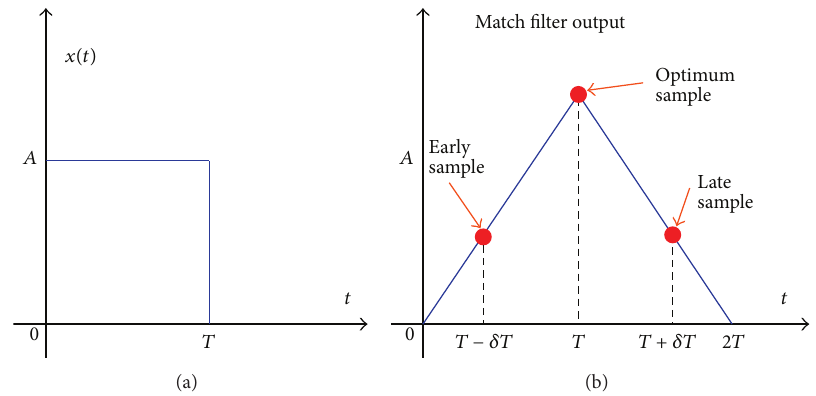
Figure 2: Rectangular signal pulse (a) and its matched filter output (b).